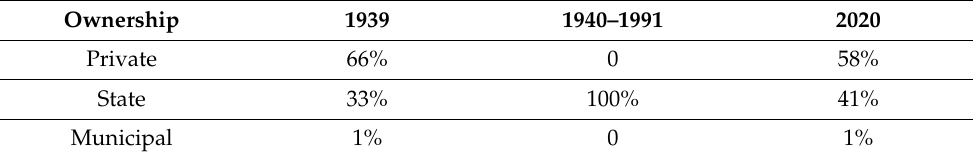
Table 2. Shares of landed property compared to the pre-war era (source: [66], p. 26).